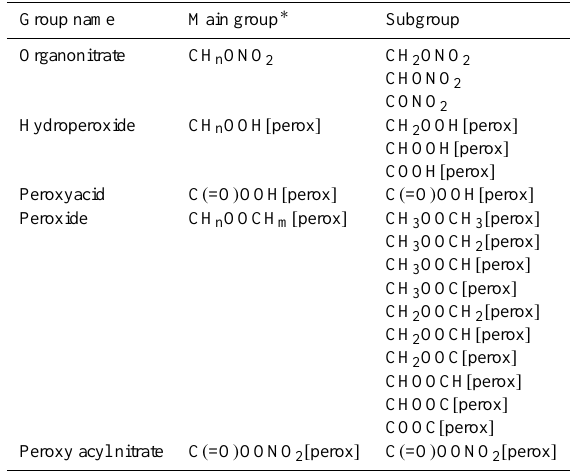
Table A1. List of new AIOMFAC main groups and corresponding